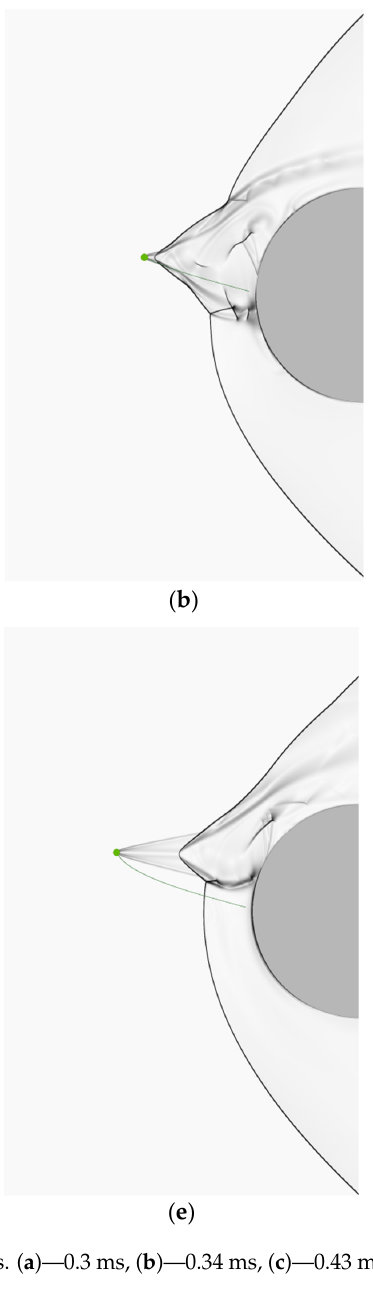
Figure 5. Distributions of pressures ( a ) and heat fluxes ( b ) along the surface at successive times for the variant with one particle. 1—initial moment, 2—0.3 ms, 3—0.53 ms, 4—0.63 ms. Consider a variant of two particles sequentially leaving the surface. Particles come out from different but close points on the surface. Figure 6 illustrates a variant when the particles’ initial angular (relative to the horizontal axis) positions are equal to 1 and 1.5 degrees. In Figure 6a, the first particle (green trajectory) crosses the shock wave, forming a perturbed region, while the second particle (red trajectory) moves in its wake and has not yet influenced the overall flow structure. In Figure 6c, the second particle crosses the shock wave and forms its perturbed region. Here, in the zone of the lower (cid:4491) -configuration, a supersonic jet directed to the surface is clearly visible. Figure 6c,d illustrates the com- bined hydrodynamic effect of particles on the shock wave structure of the flow. It is char- acteristic that the zone of action of the impact jet on the surface remains fairly stable